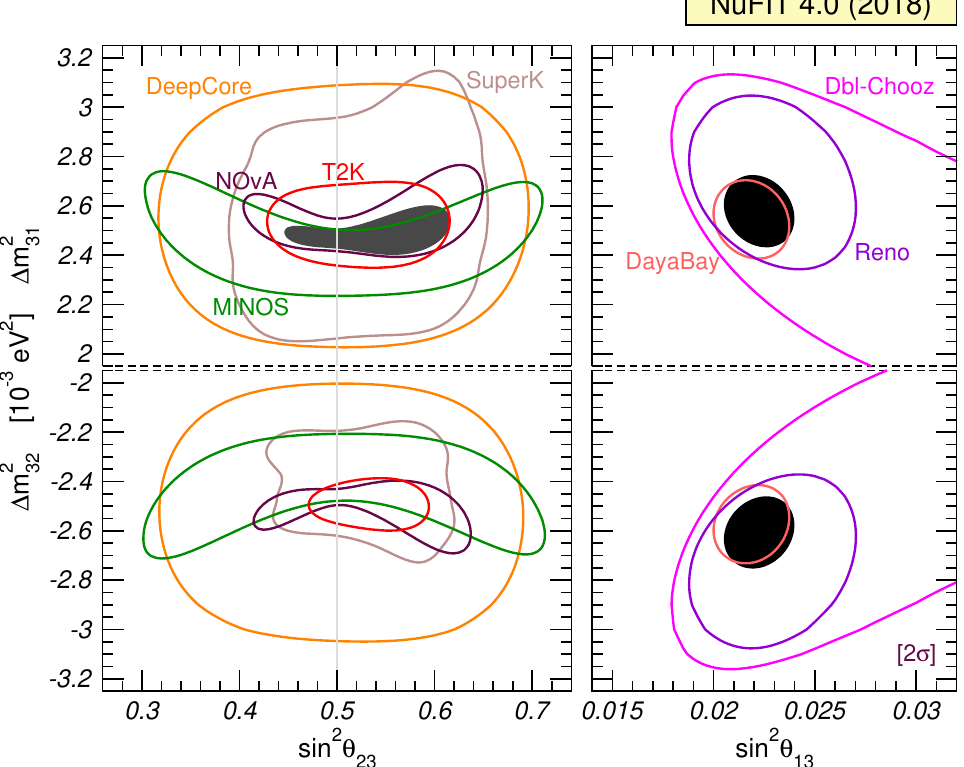
Figure 5 . Determination of (cid:1) m 2 at 2 (cid:27) (2 dof), where ‘ = 1 for NO (upper panels) and ‘ = 2 3 ‘ for IO (lower panels). The left panels show regions in the ( (cid:18) 23 ; (cid:1) m 2 ) plane using both appear- 3 ‘ ance and disappearance data from MINOS (green), T2K (red), NOvA (dark-redwood), as well as IceCube/DeepCore (orange), and SK-atm (from the table provided by the experiment, light-brown line) and the combination of them (dark-grey coloured region). In the left panels the constraint on (cid:18) 13 from the global (cid:12)t (which is dominated by the reactor data) is imposed as a Gaussian bias. The right panels show regions in the ( (cid:18) 13 ; (cid:1) m 2 ) plane using only Daya Bay (pink), Reno (violet) 3 ‘ and Double Chooz (magenta) reactor data, and their combination (black coloured region). In all panels (cid:1) m 2 , sin 2 (cid:18) 12 are (cid:12)xed to the global best (cid:12)t values. Contours are de(cid:12)ned with respect to 21 the global minimum of the two